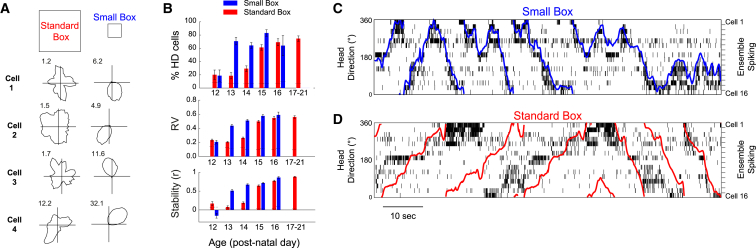
HD Cell Signaling Is Stabilized When Rats Explore a Small (20 cm Side) Environment, from P13 Onward(A) Example firing rate polar plots for 4 HD cells recorded at P13 in the standard (left) and small (right) boxes. Numbers at top left indicate peak firing rate (Hz).(B) HD cells are more numerous (top) and have a higher spatial tuning (Rayleigh vector [RV], middle) and intra-trial stability (bottom) when recorded in a small versus a standard box in animals older than P13. Error bars indicate SEM. See also Figure S1.(C and D) HD cell network internal organization is preserved in the standard box, even when directional signaling is unstable. Colored traces indicate the rat’s actual head direction, overlaid upon spike raster plots for all simultaneously recorded HD cells, in the small (C) and standard (D) boxes. For both (C) and (D), HD cells are ordered vertically by their preferred firing direction in the small box. The sequences of HD cell activation for each head turn direction are similar in the small and standard boxes, but the direction signaled by HD cell firing consistently undershoots actual rotation in the standard box.